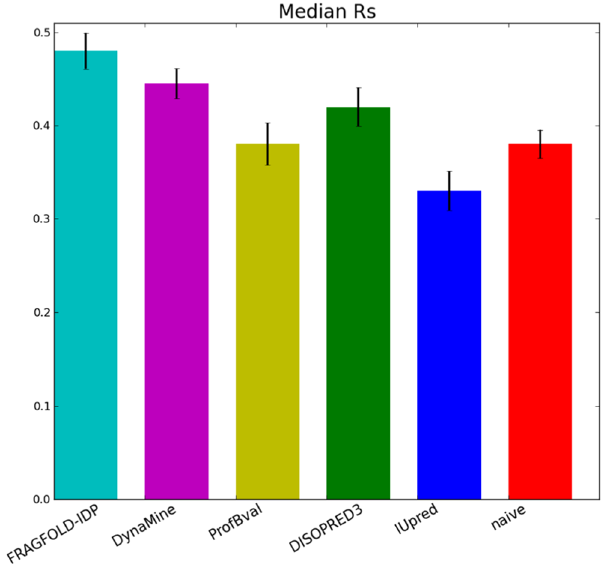
Figure 4. Median R S values between FRAGFOLD-IDP and other computational techniques.